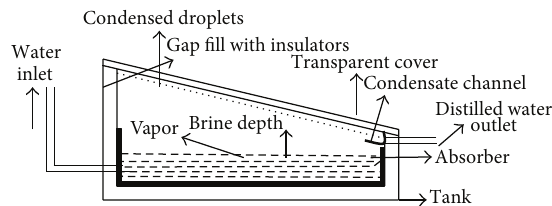
Figure 1: Schematic diagram of a conventional type single slope solar still.